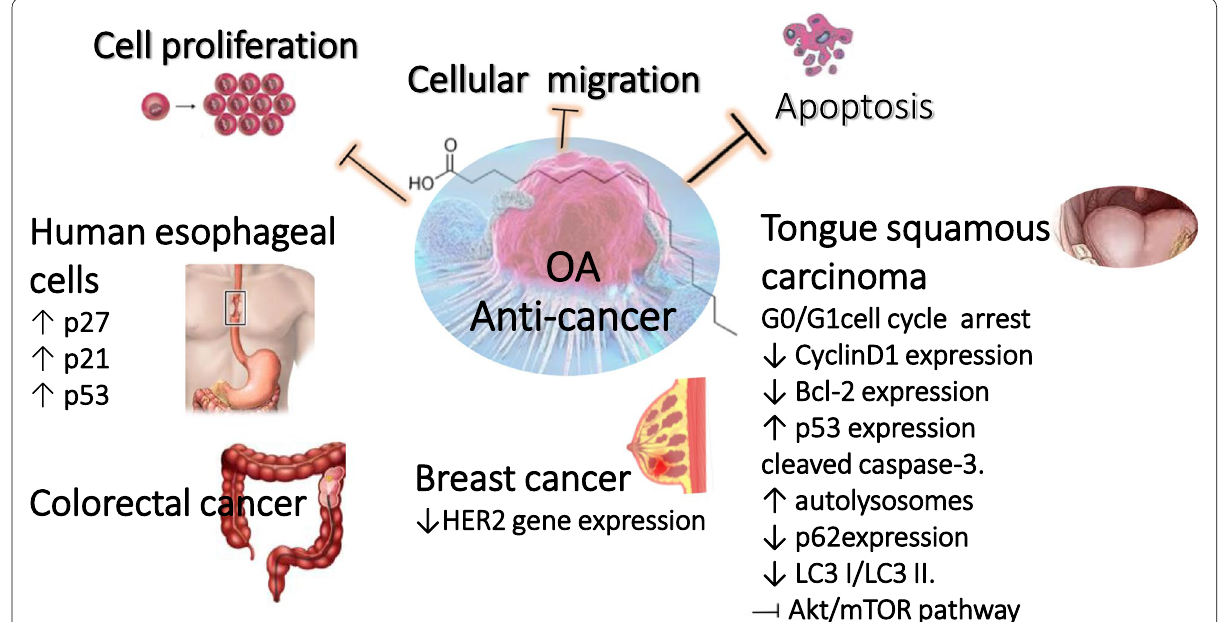
Fig. 4 Summary of oleic acid (OA) action mechanisms as anti-tumor agent in different cancer